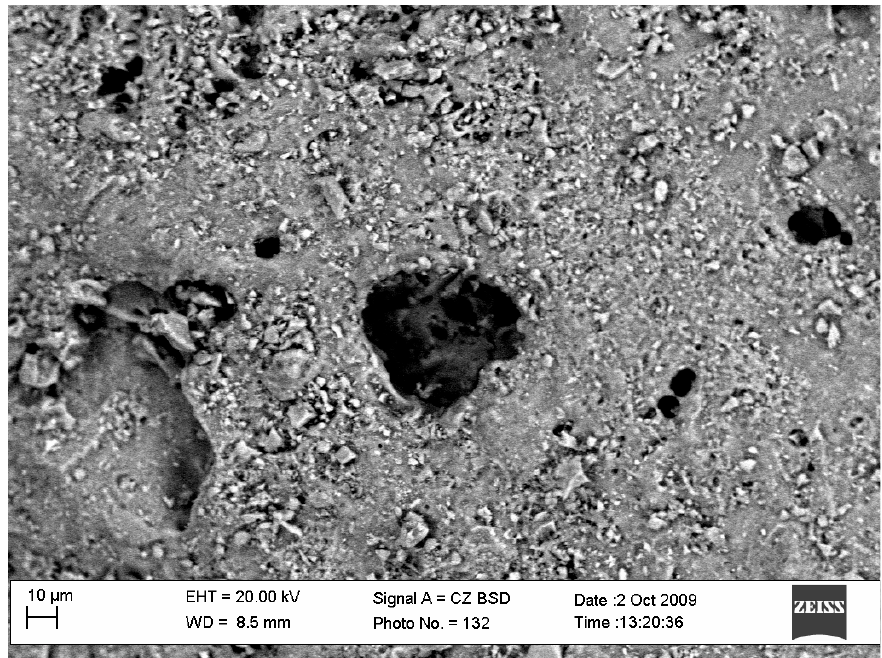
Figure 2. Microstructure of a ceramzite granule.